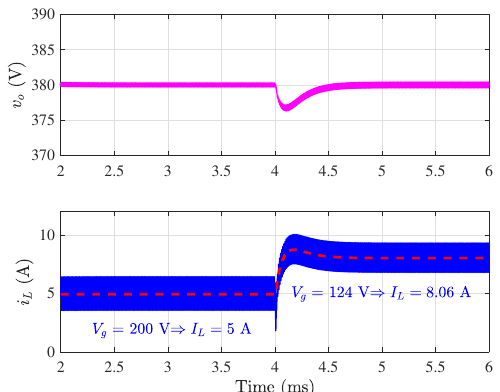
Figure 16. Small-signal transient response in front of a 38% step change in the input voltage from 200 V to 124 V using numerical simulations using a detailed switched model implemented in PSIM c (cid:13) and the discrete-time model.